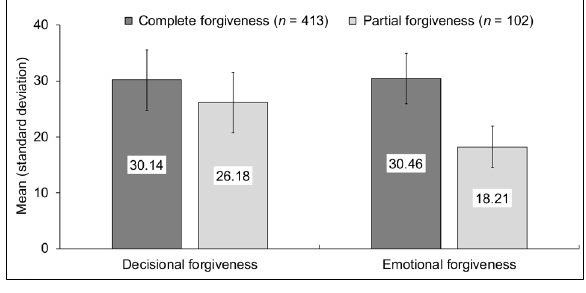
Profiles indicating decisional and emotional forgiveness of partner.